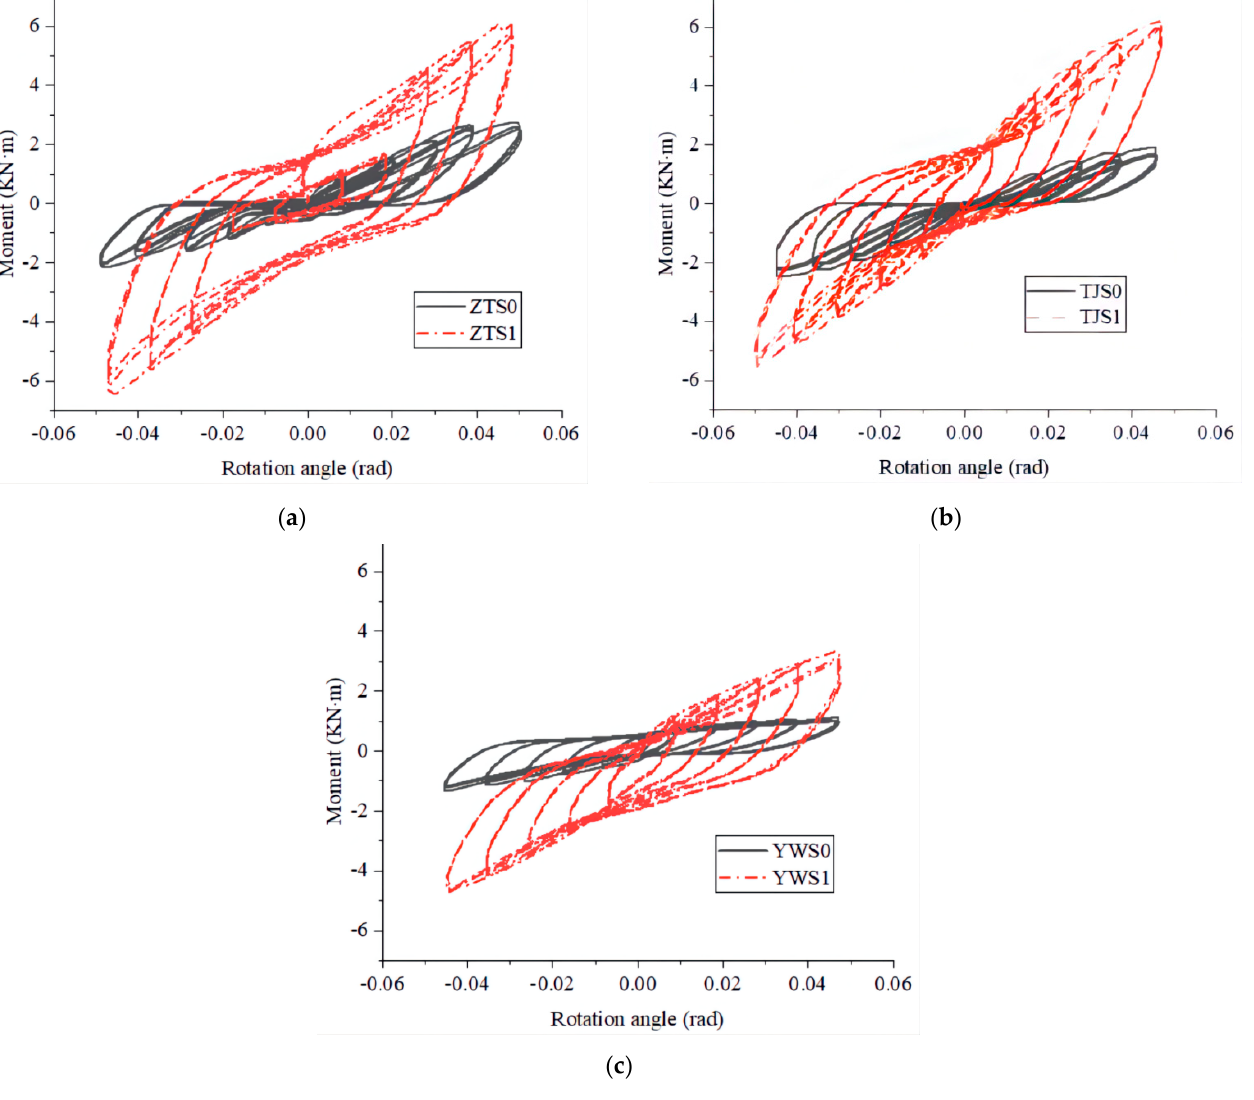
Figure 8. Comparison of M- θ curves of three types of tenon joints before and after